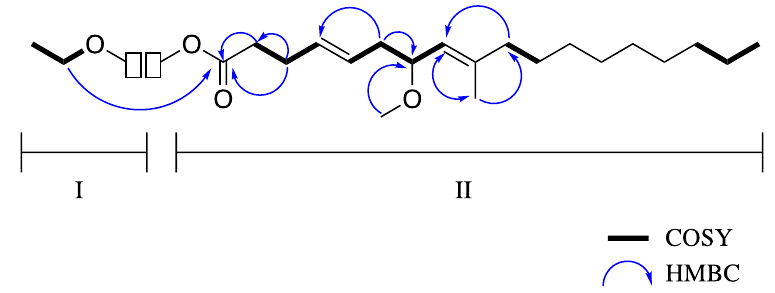
Table 2. NMR Spectroscopic data for Compound 2 in CDCl